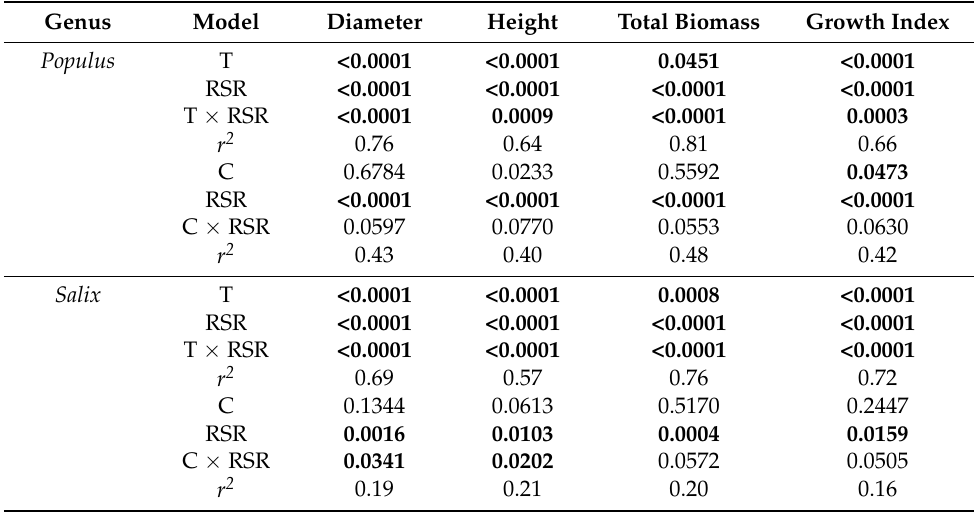
Table 6. Results of analyses of covariance (ANCOVA) (i.e., p -values from F -tests of model effects and model r 2 values) for diameter, height, total dry biomass, and growth index in a study assessing the relationships among root–shoot allocations, early growth, and health of hybrid poplar and willow clones when grown for 65 days in soils from five landfills in eastern Wisconsin, USA.